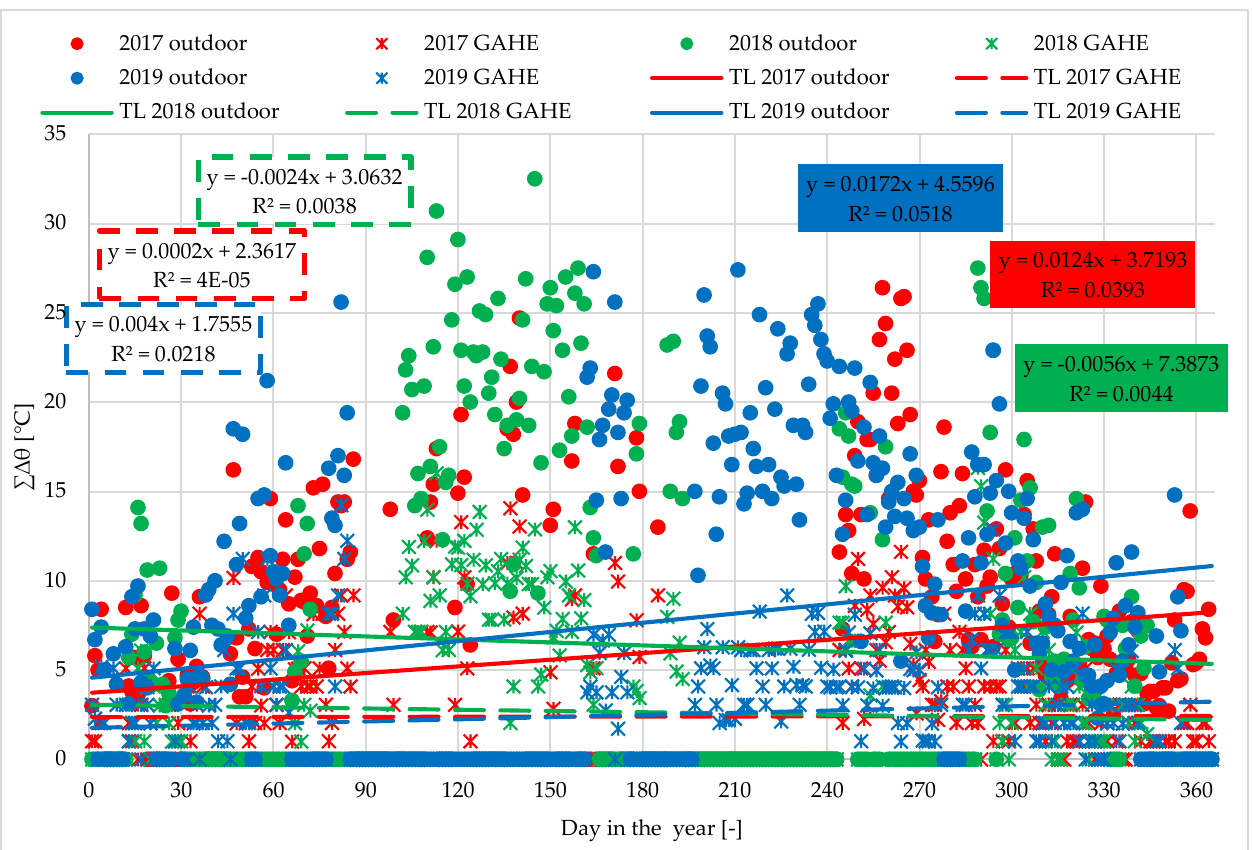
Figure 6. Daily sum of absolute changes in ambient temperature and temperature at the GAHE outlet between two consecutive hours.